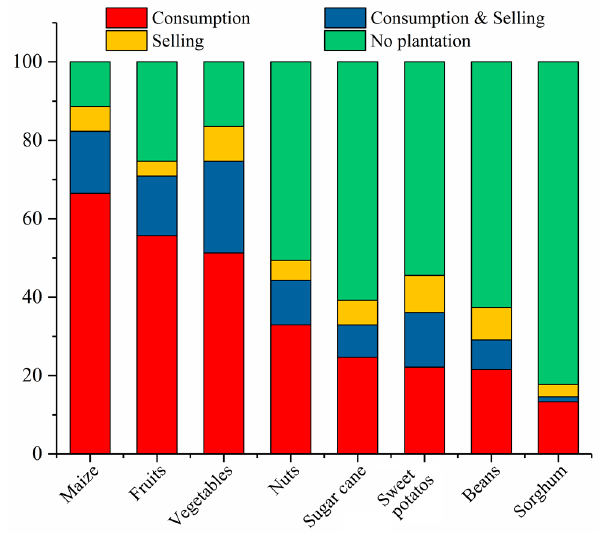
Figure 8. Common crops cultivated in the Nzhelele and Levuvhu river catchments.